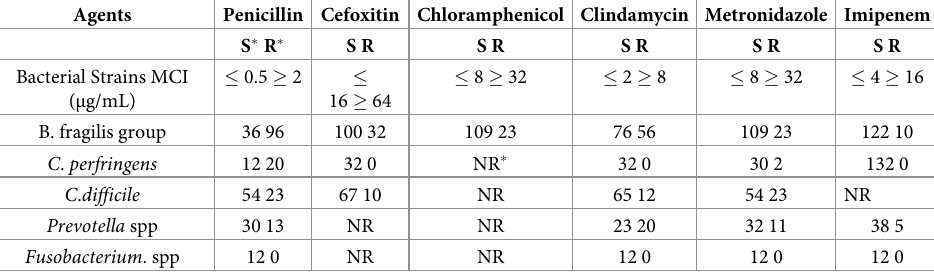
Table 5. Antimicrobial susceptibility of anaerobic bacterial.